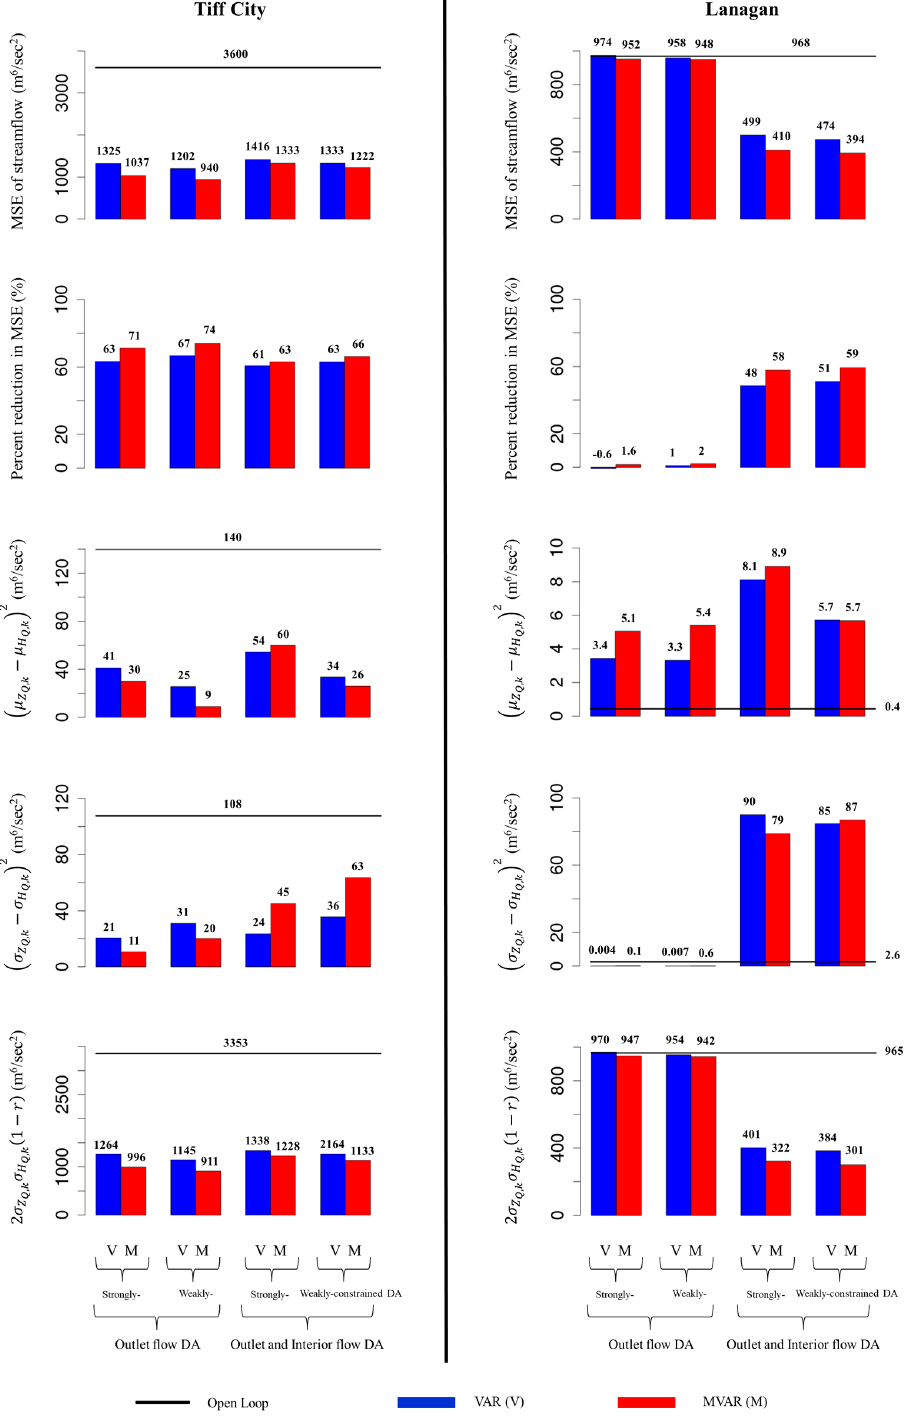
Figure 9. Mean Squared Error (MSE) of streamflow analysis generated from VAR (V) or MVAR (M) and its decomposition (Equation (18)) where µ Z City, and 30 (m 3 /s) and 43 (m 3 /s) for Lanagan.